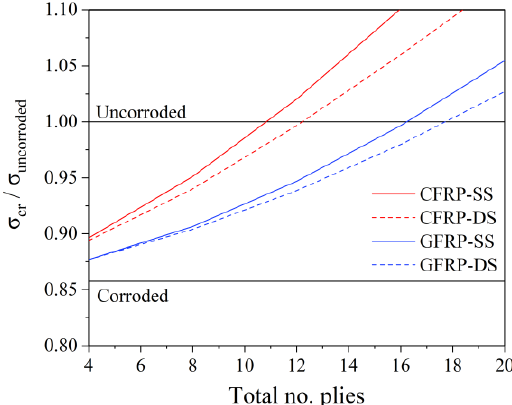
Figure 8. OFAT analysis for different patch’s materials and configurations.